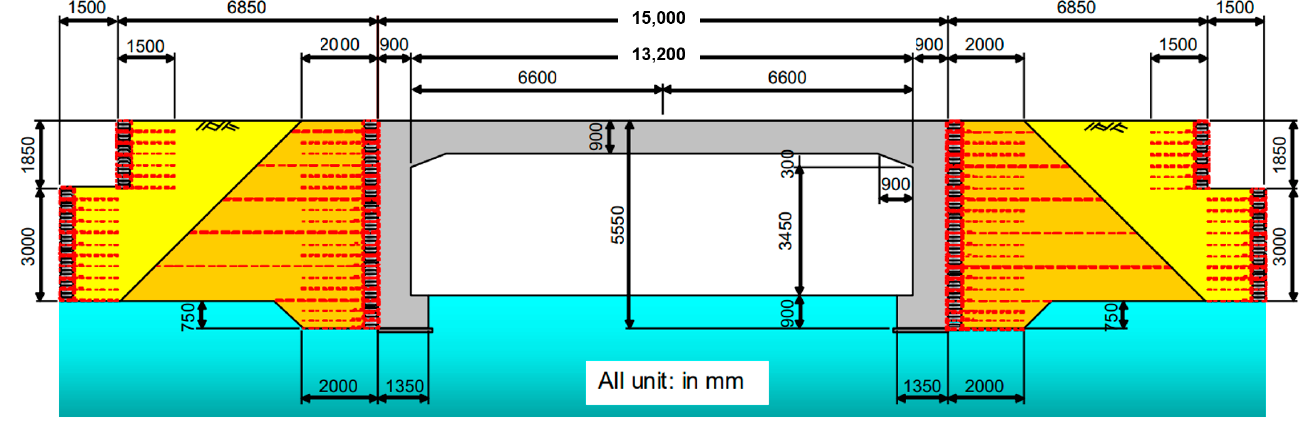
Figure 2. GRS integral bridge full-scale model design [14].